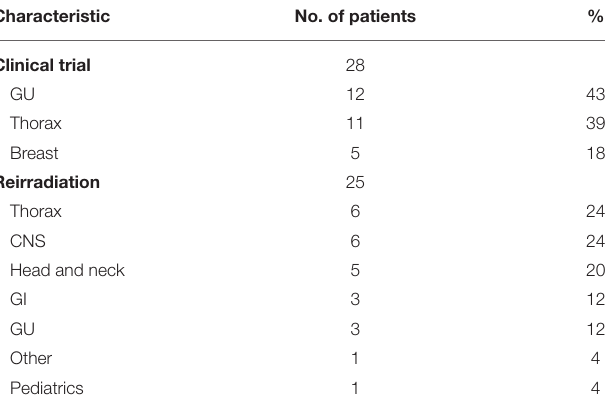
TABLE 1 | Patient and treatment characteristics. TABLE 2 | Clinical trial involvement and reirradiation